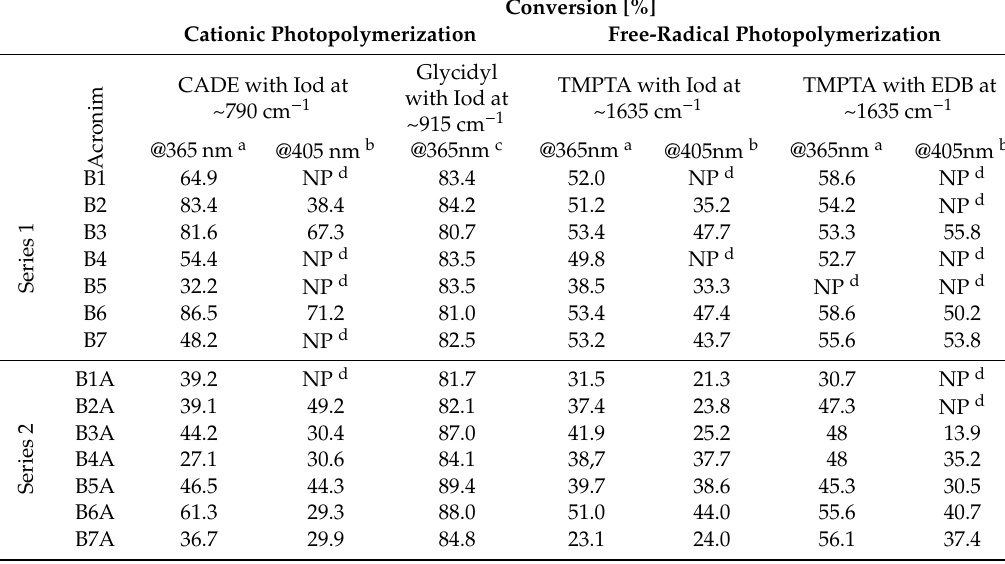
Table 2. Summary of functional group conversions of used monomers for various photopolymerization processes, with the use of the 2-amino-4-methyl-6-phenyl-benzene -1,3-dicarbonitrile